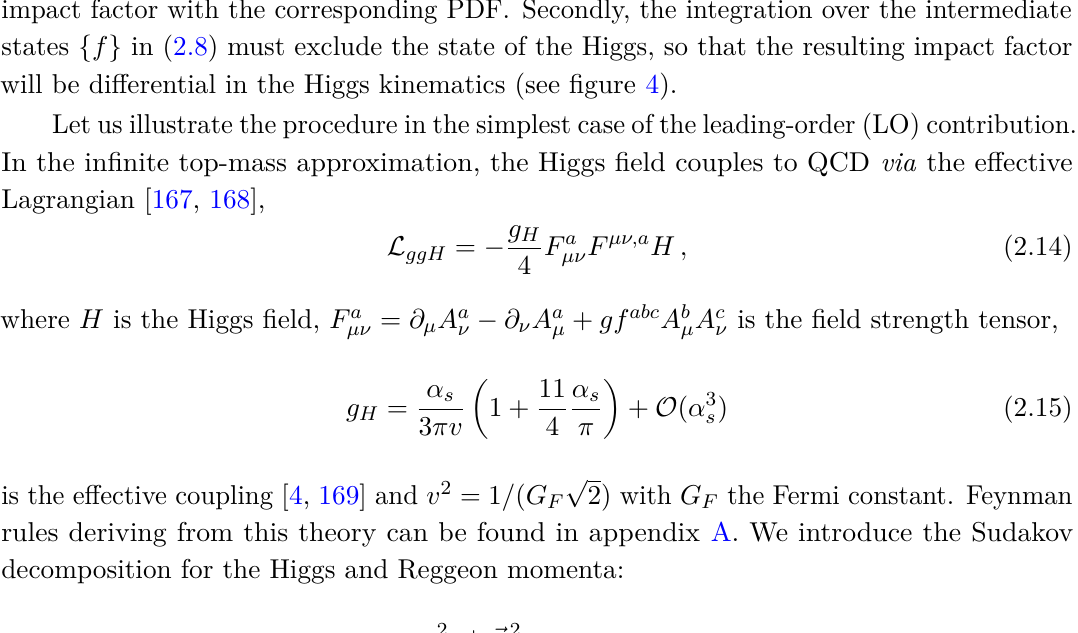
is its transverse H